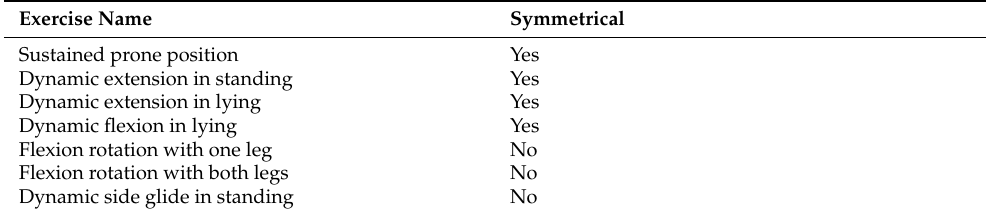
Table A2. Low-back physiotherapy exercises used in the